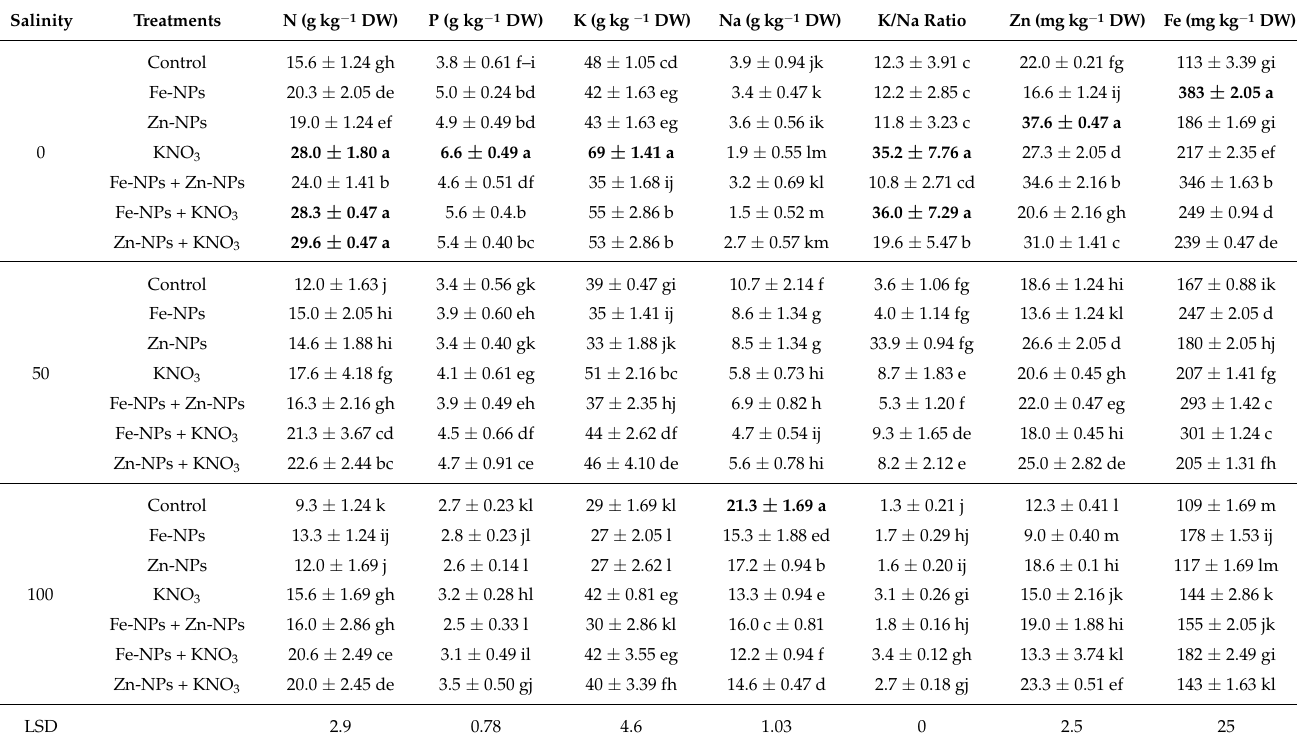
Table 7. The effect of salinity and foliar applications (without spraying, potassium nitrate, and Zn and Fe nanoparticles) on minerals content of Aloe vera